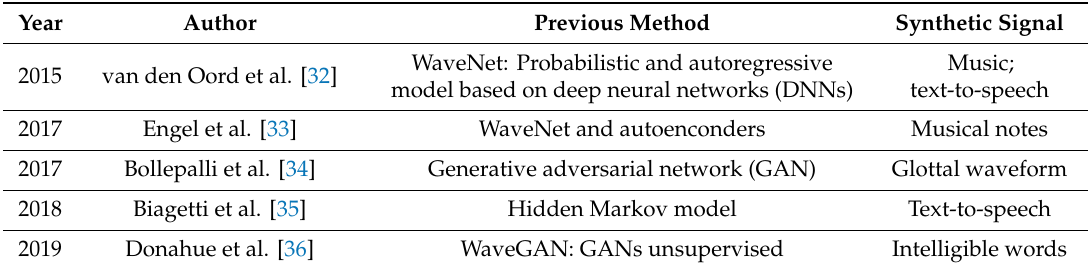
Table 2. Previous methods for generation of synthetic